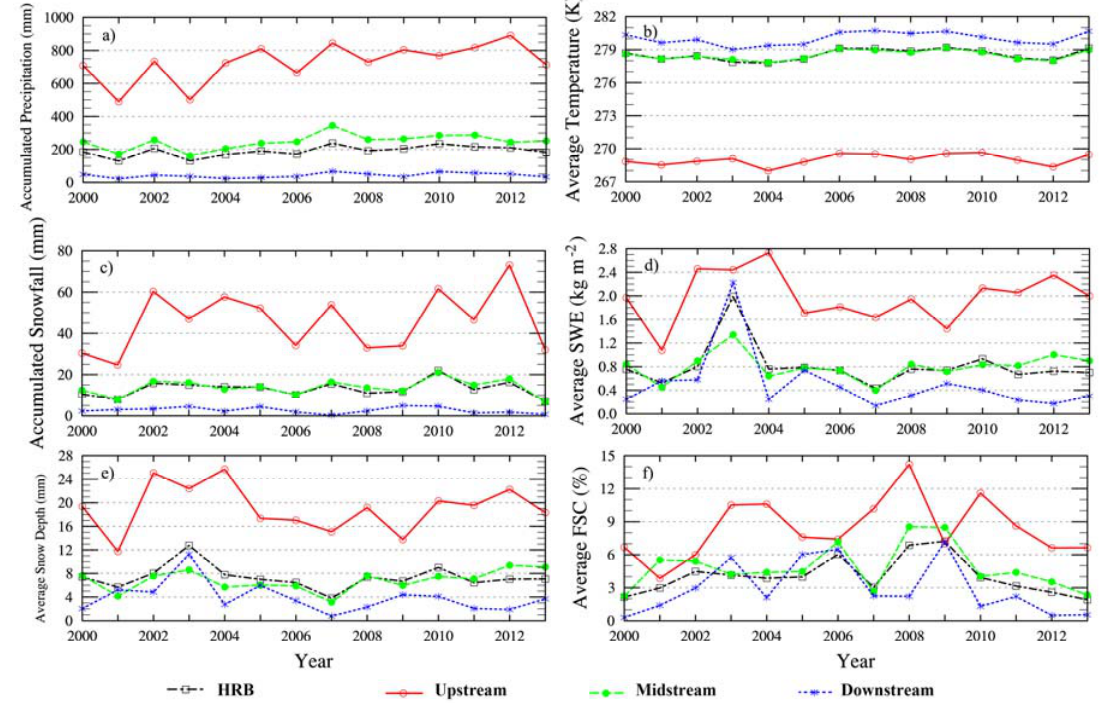
Figure 5. Annual mean values across the Heihe River Basin (HRB) and its sub-basins from 2000 to 2013: ( a ) precipitation; ( b ) 2m temperature; ( c ) snowfall; ( d ) SWE; ( e ) snow depth; ( f ) FSC.